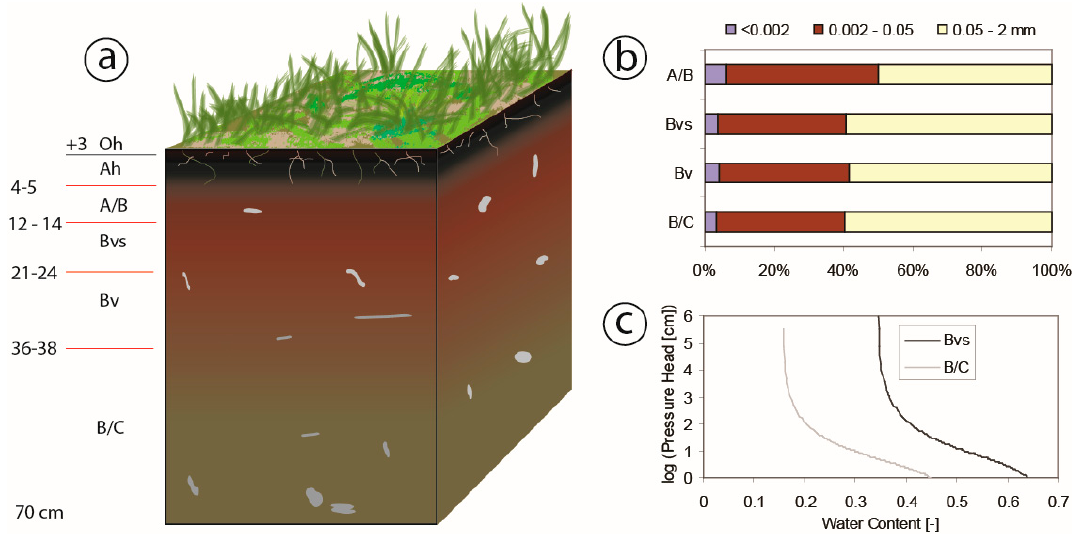
Figure 2. ( a ) Sketch of soil condition at different depths in the study plot (unit of depth is cm). ( b ) Soil layer and soil texture are based on the Czech soil classification: < 0.002 mm clay particles, 0.002–0.05 mm slit particles, and 0.05–2 mm sand particles. ( c ) Water retention curves measured at a depth of 20 cm (Bvs) and 60 cm (B / C) below the surface.